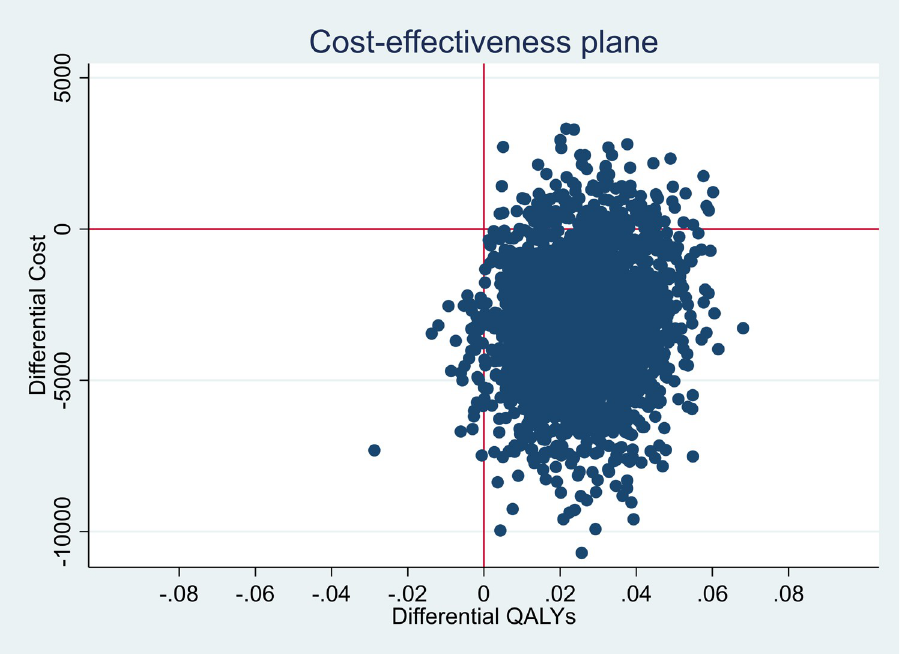
Fig 2. Cost-effectiveness plane for all countries. Note: The X-axis shows the difference in QALYs between the OPERAM trial arms: a positive QALY difference means an increase in QALYs in the intervention arm and is represented on the right-hand side. By contrast, a negative QALY difference is represented on the left-hand side. The Y-axis shows the cost differential. If the intervention is associated with a cost reduction, the cost differential is negative (lower part of the graph), while a positive cost differential (upper part of the graph) indicates an increase in costs due to the intervention.